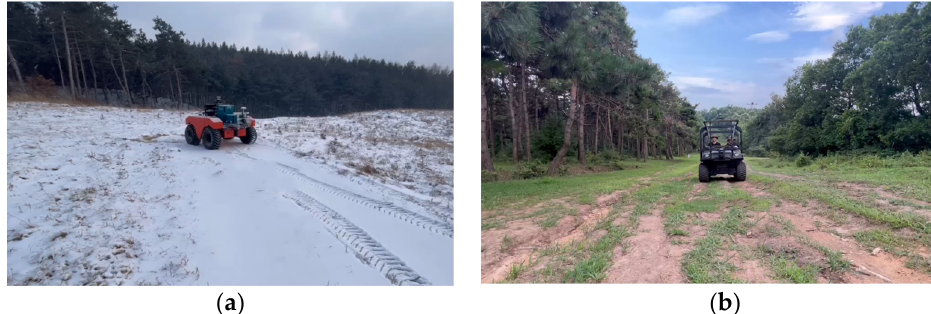
Figure 7. The collecting platform: ( a ) J5; ( b ) Avenger.